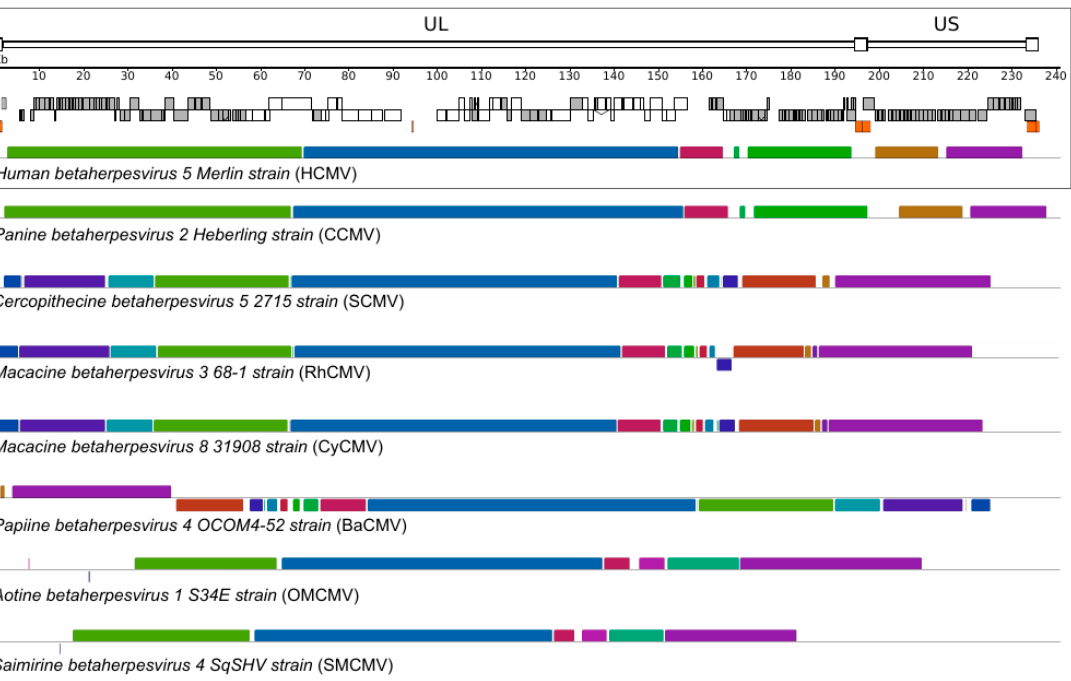
Figure 1. Primate CMV genome organization . A schematic representation of the HCMV genome is shown in the upper panel. Annotated coding regions are represented as boxes (white: core genes, gray: non–core genes); repetitive elements are shown as orange boxes. Colored similarity plots with primate CMV genomes are also shown. The whole–genome CMV alignment was obtained with progressive MAUVE [16,17]. Each genome is laid out in a horizontal track and each colored block delimits a genome region that aligns to part of another genome (presumably homologous and free from internal rearrangements) and thus represents a locally collinear block. When the similarity plot points downward it indicates an alignment to the reverse strand of the genome. Genome IDs: HCMV, NC_006273; CCMV, NC_003521; SMCV, NC_012783; RhCMV, NC_006150; CyCMV, NC_033176; BaCMV, NC_027016; OMCMV, NC_016447; SMCMV, NC_016448 .